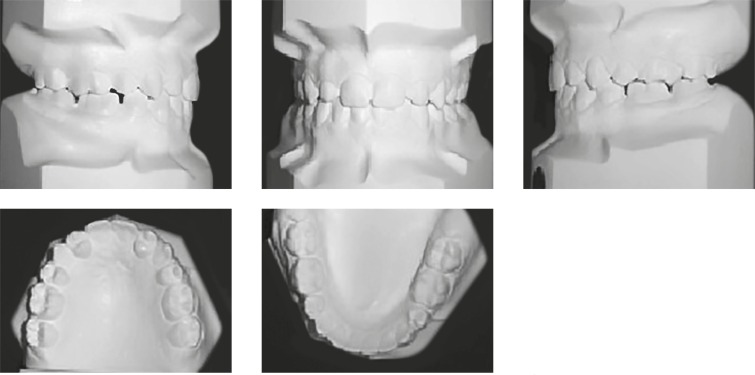
Final dental casts.